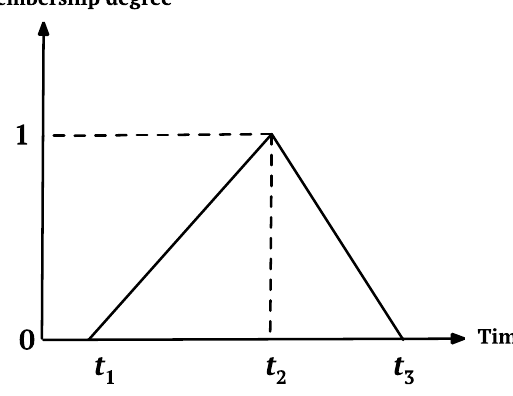
Figure 5. Uncertain time formulated by triangular fuzzy number.